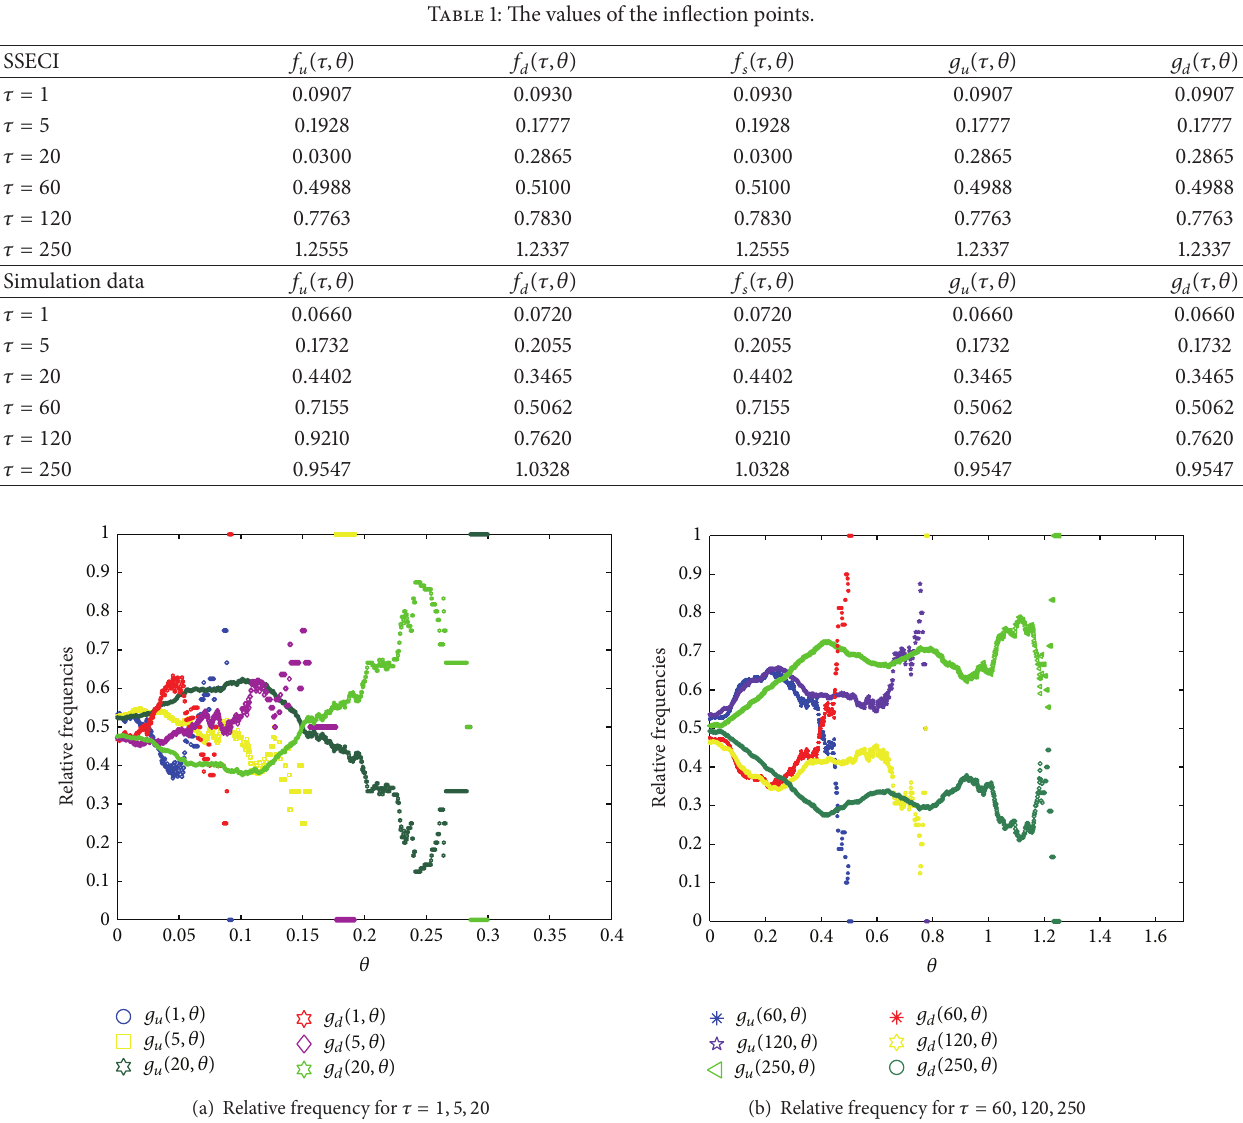
Figure 3: The evolution trends of relative frequencies of the actual data for SSECI with the random variable 𝜃